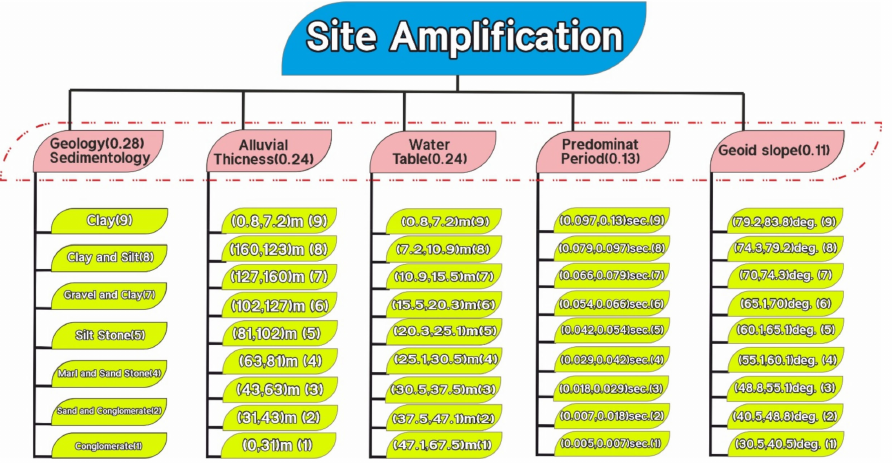
Figure 5. Final analytical hierarchy process adoption for the influential